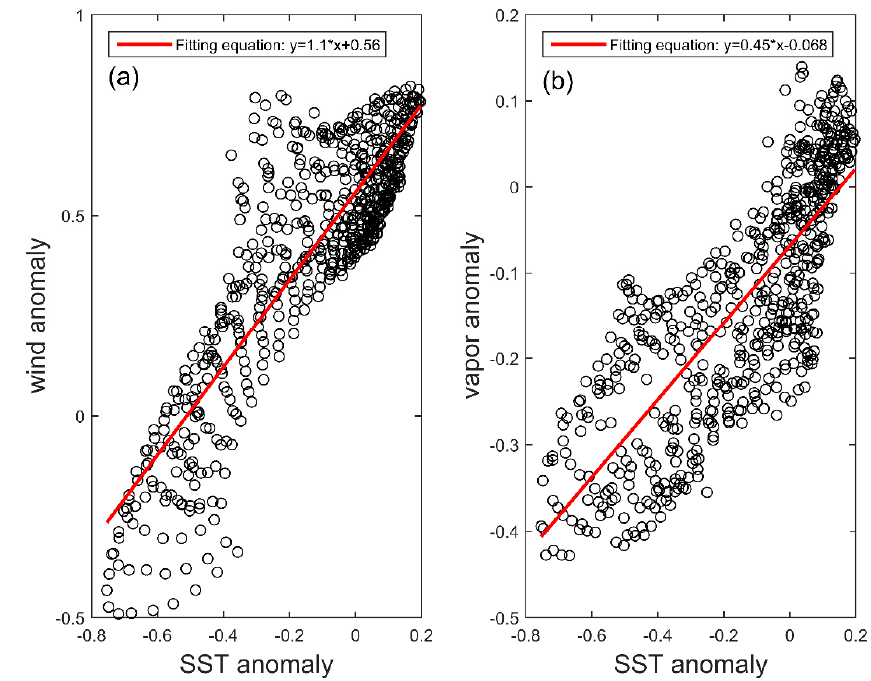
Figure 12. The wind speed anomaly (( a ), units: m · s − 1 ) and the water vapor anomaly (( b ), units: mm) fitting with the SST anomaly, respectively (red line is the linear fitting line).